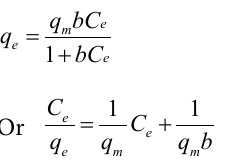
Table 2. Comparatively low correlation coefficients ( R 2 ) for the Elovich kinetic model reveal that this adsorption is not fitted with this kinetic model.